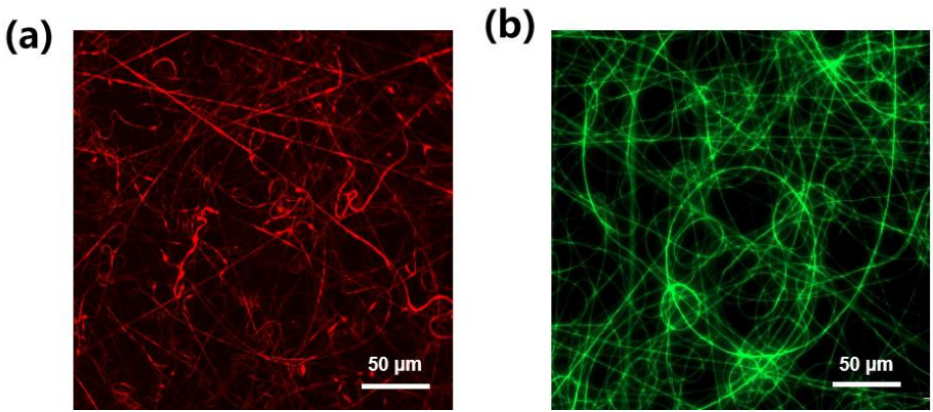
Figure 3. Phosphorescence and fluorescence micrograph of F1 nanofibers ( λ ex = 385 nm, λ em = 650 nm) ( a ) and F2 nanofibers ( λ ex = 470 nm, λ em = 520 nm) ( b ). The hydrophobicity/hydrophilicity of the four different films were determined by a water contact angle experiment (Figure 4). F4 is the original pure CA electrospun film,